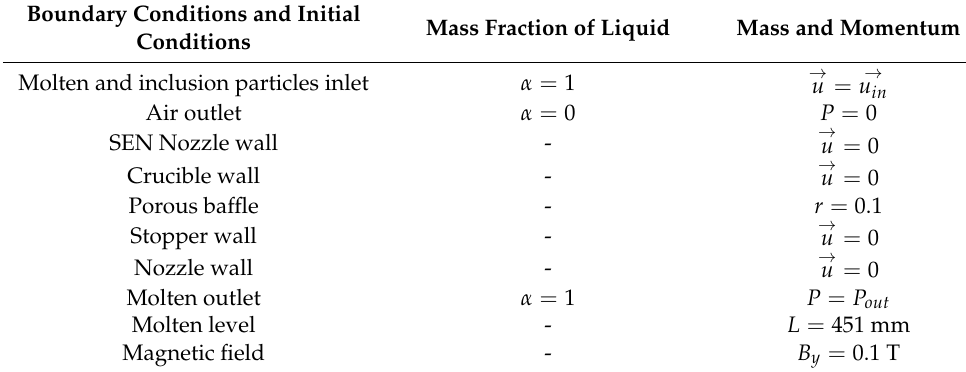
Table 2. Boundary conditions and initial conditions adopted in the simulation. Boundary Conditions and